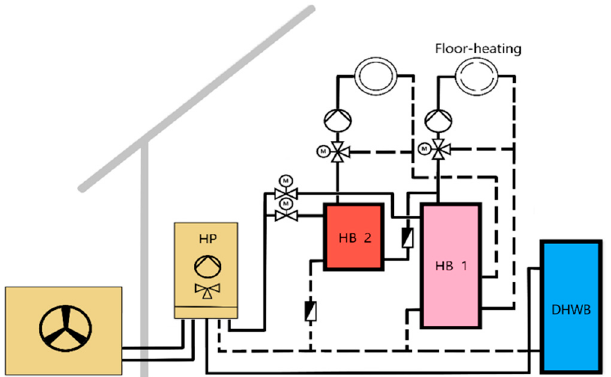
Figure 4. The existing HS diagram in the test building. Main components: HP Vitocal 200S, HB 1